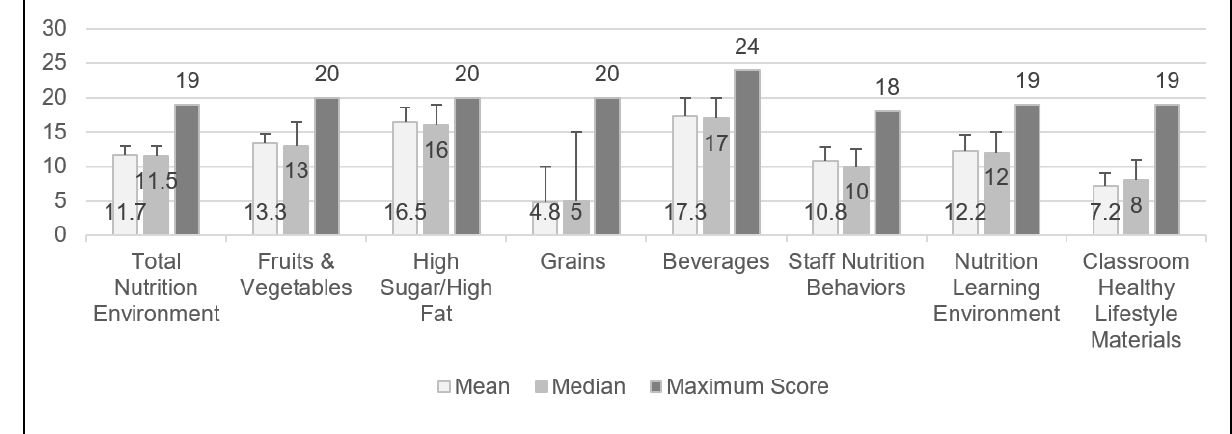
Figure 1. Nutrition environment total and sub scores of Oklahoma Family Child Care Homes as determined by the Environment and Policy Assessment and Observation (EPAO) tool ( n = 51). (A second observation visit was not completed for two of the Family Child Care Home providers; therefore, the EPAO data during lunchtime were based on only one observation visit.)